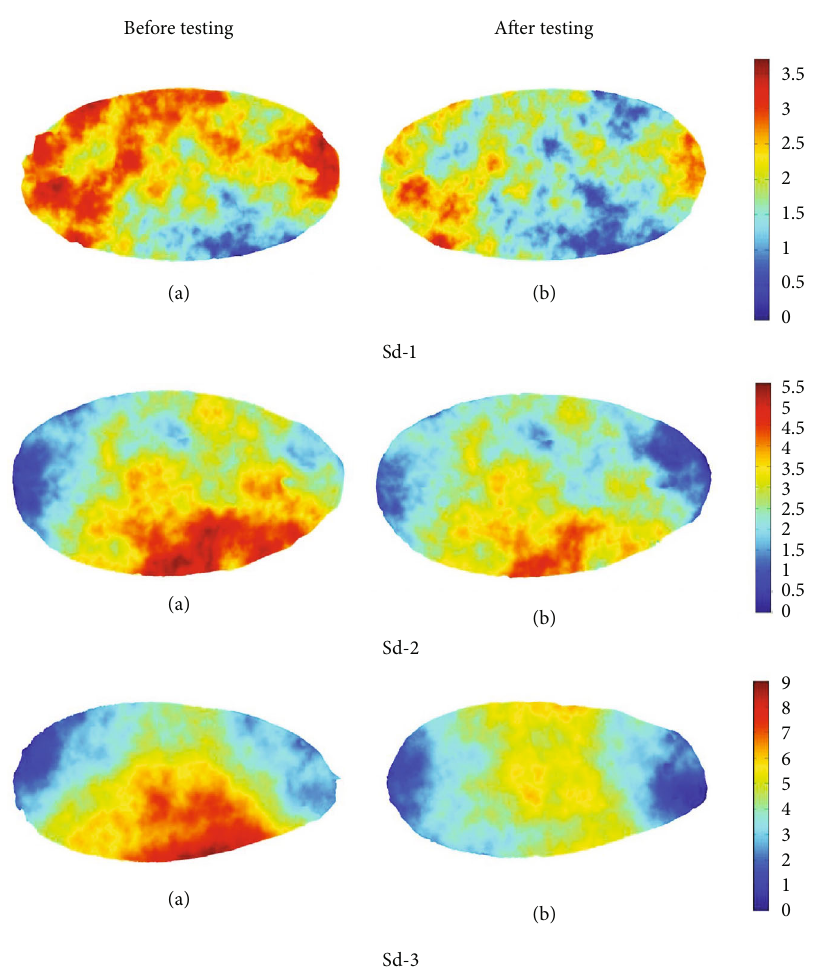
Figure 10: (a, b) Surface scans of samples Sd-1, Sd-2, and Sd-3 before and after testing under dynamic